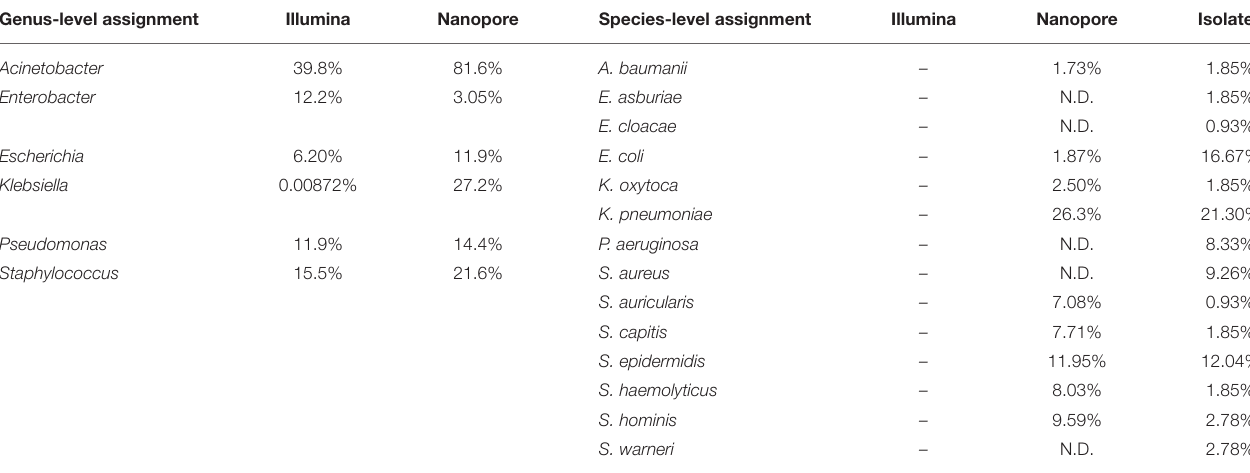
TABLE 1 | Detection of clinical pathogens by Illumina and Nanopore at genus-level and